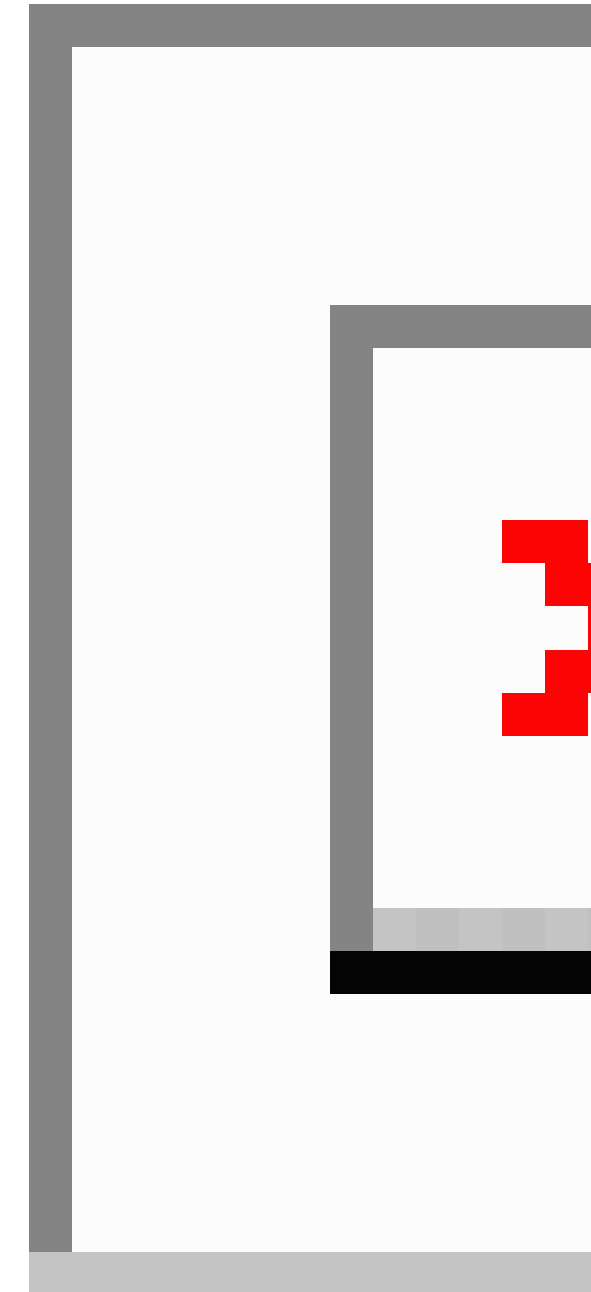
Figure 1. Steps in program